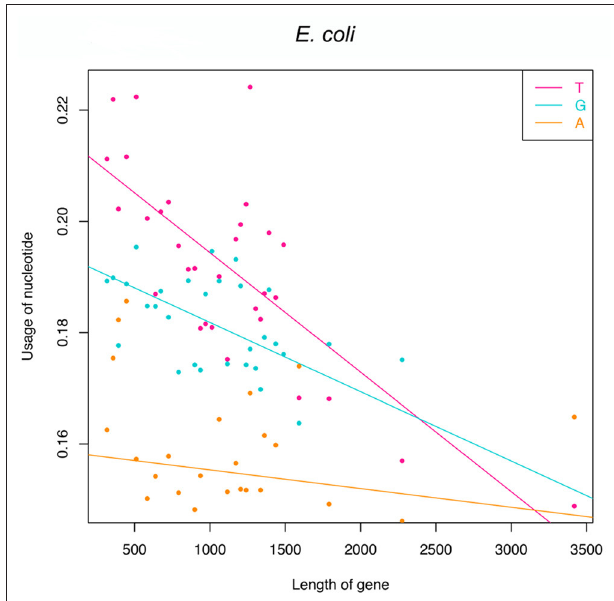
FIGURE 2 | Linear regression analyses of frequencies of T, G, and A against gene length. Note that 513 genes are divided into 30 groups based on their